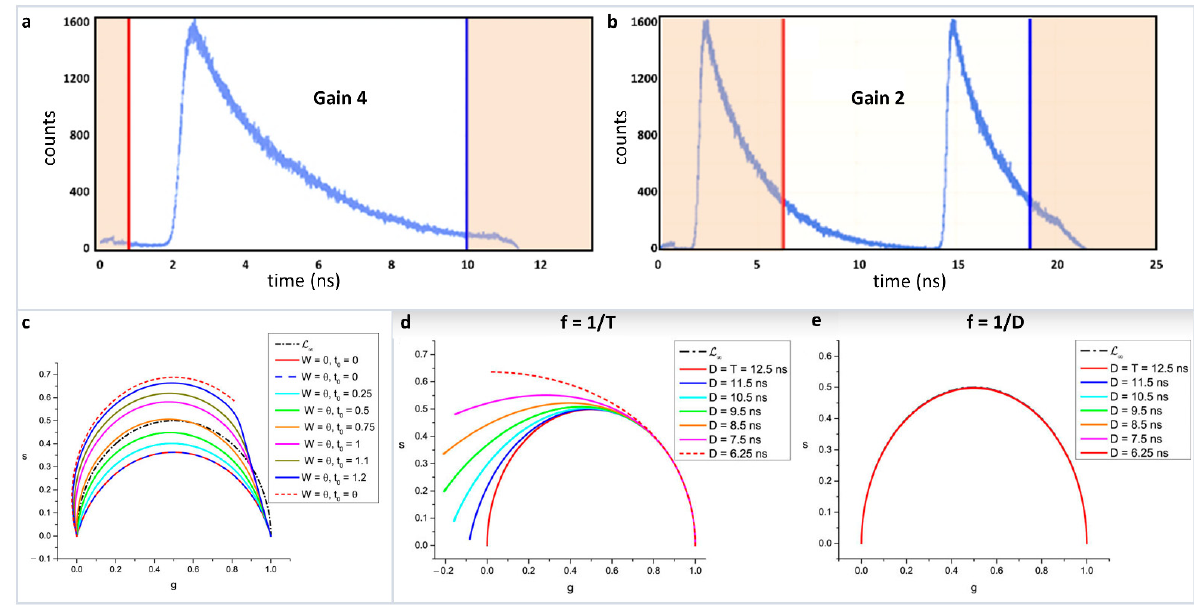
Figure 5. Improper transformation of fluorescence lifetime decays to phasor plots and their